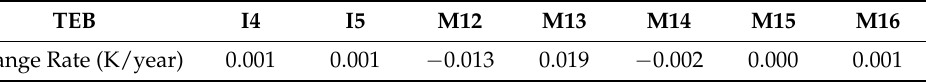
Figure 12. S-NPP VIIRS bands M13 and M15 BT and in situ SST over ocean scene near Hawaii Islands. Results between VIIRS and SST are collocated in space and coincident in time. The brightness temperatures for the VIIRS bands are monthly-averaged. The in situ SST are nighttime observations only. Time series start on 20 January 2012. Data gaps in SST observations are due to outages. Table 5. S-NPP VIIRS-buoy temperature change rates for each TEB. VIIRS data are L1B calibrated radiance converted to BT. Buoy data are SST observations. Both datasets are collocated in space and coincident in time.